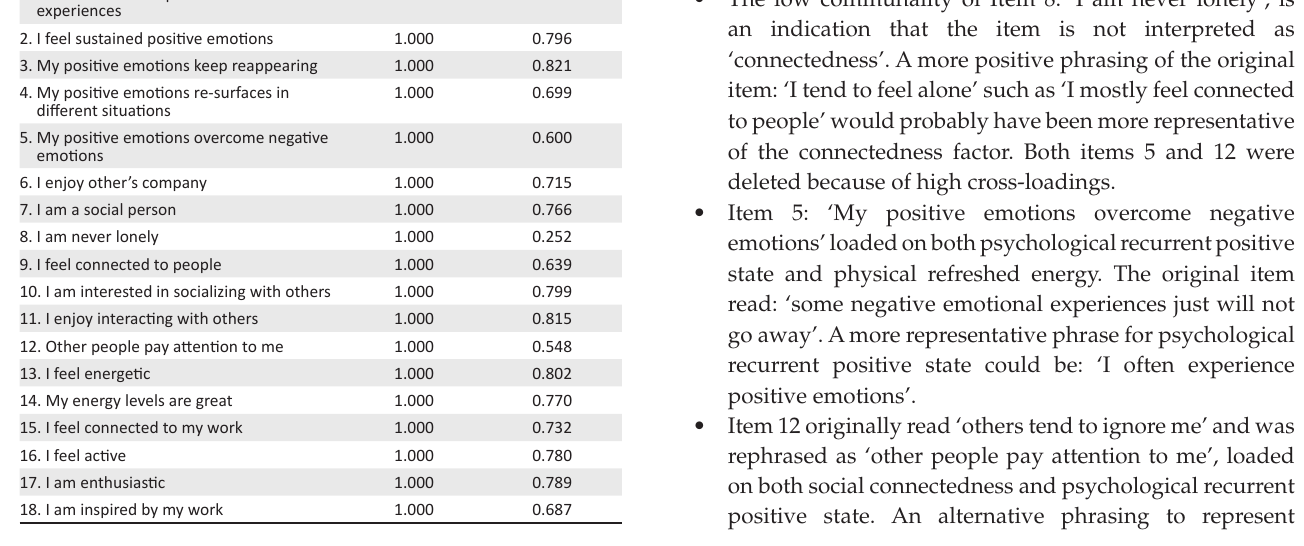
TABLE 3: Eigen values and total explained variance. Component Initial Eigenvalues Extraction Sums of Squared Loadings Total % Variance Cumulative % Total % Variance Cumulative